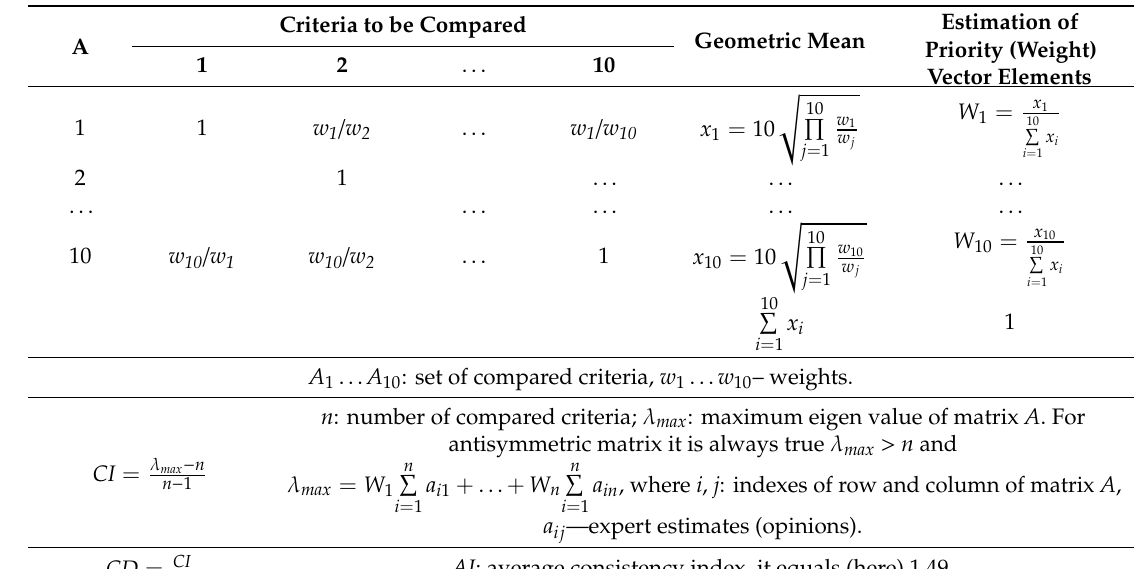
Table 2. Diagram of weight estimation